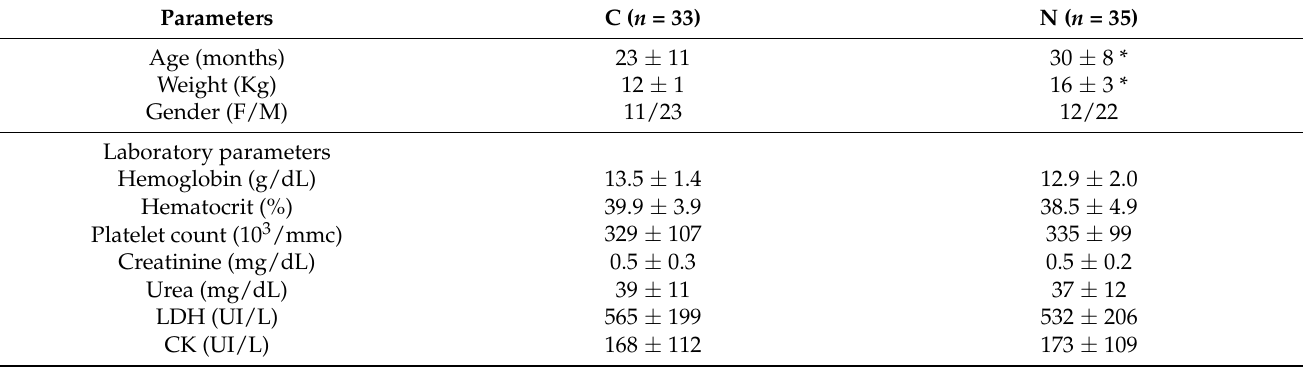
Table 1. General characteristics, laboratory parameters and main interventions in cyanotic (C) and non-cyanotic congenital heart disease (N) children admitted into the study. Data are expressed as means ± SD. * p <